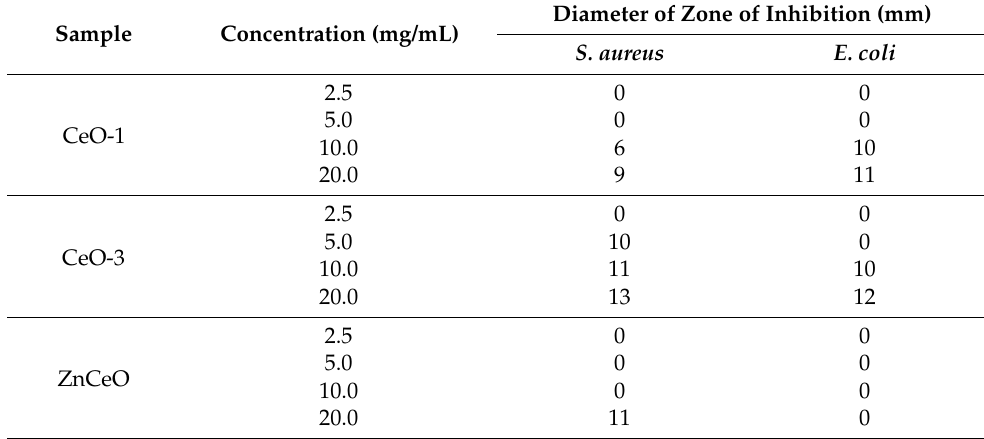
Table 4. Antimicrobial activity of cerium oxide nanoparticles against bacterial pathogens. Sample Concentration